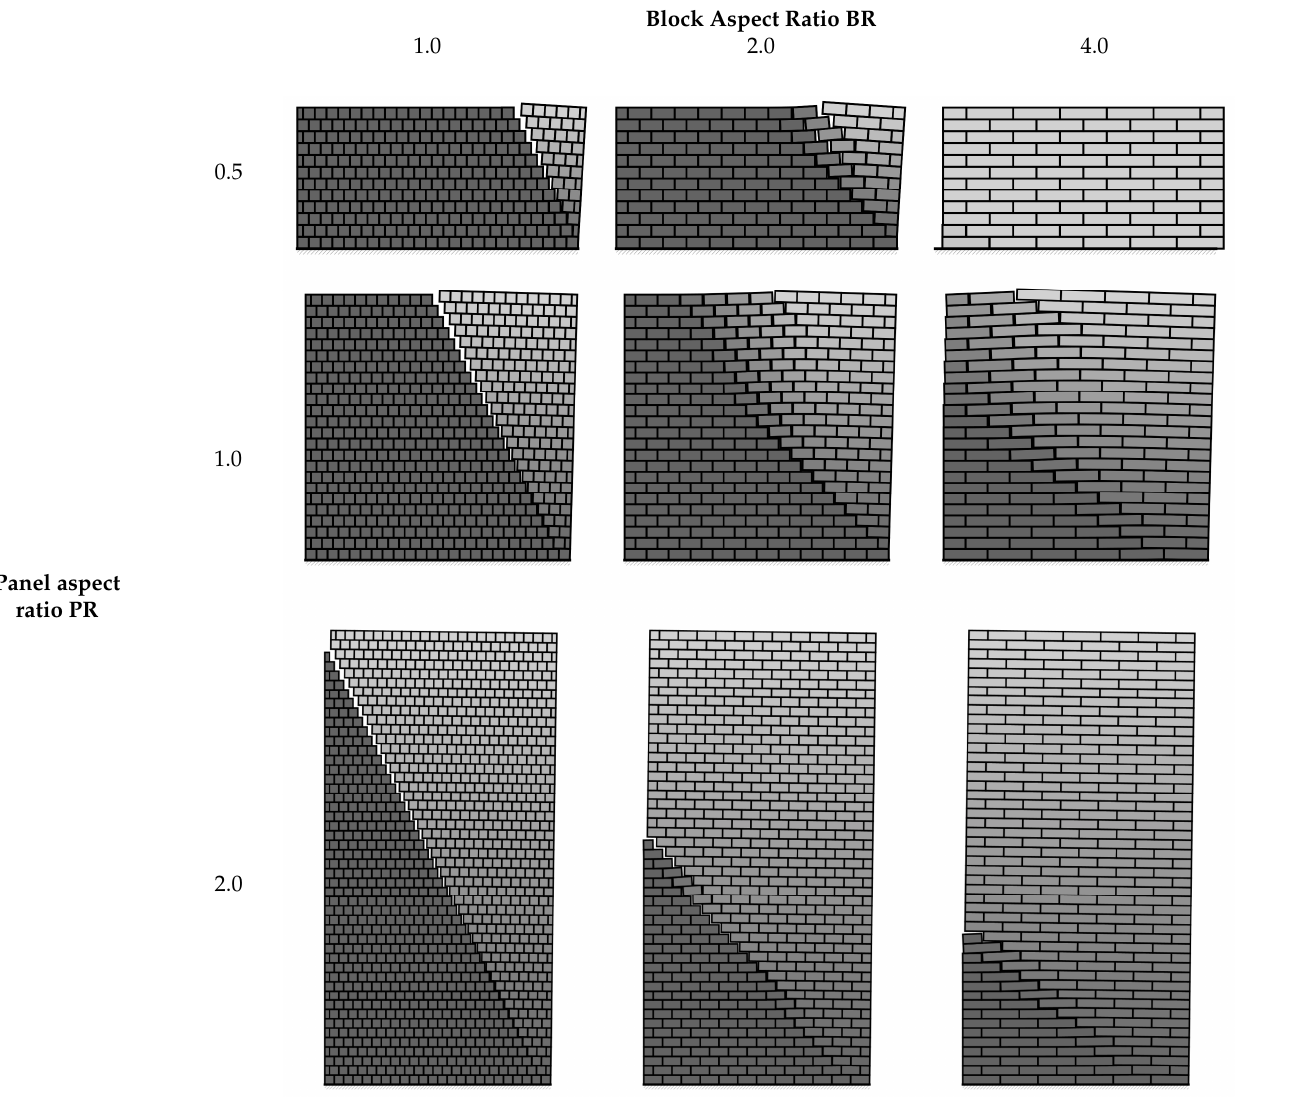
Table A3. Failure Mechanisms for Running Bond with µ = 0.8.